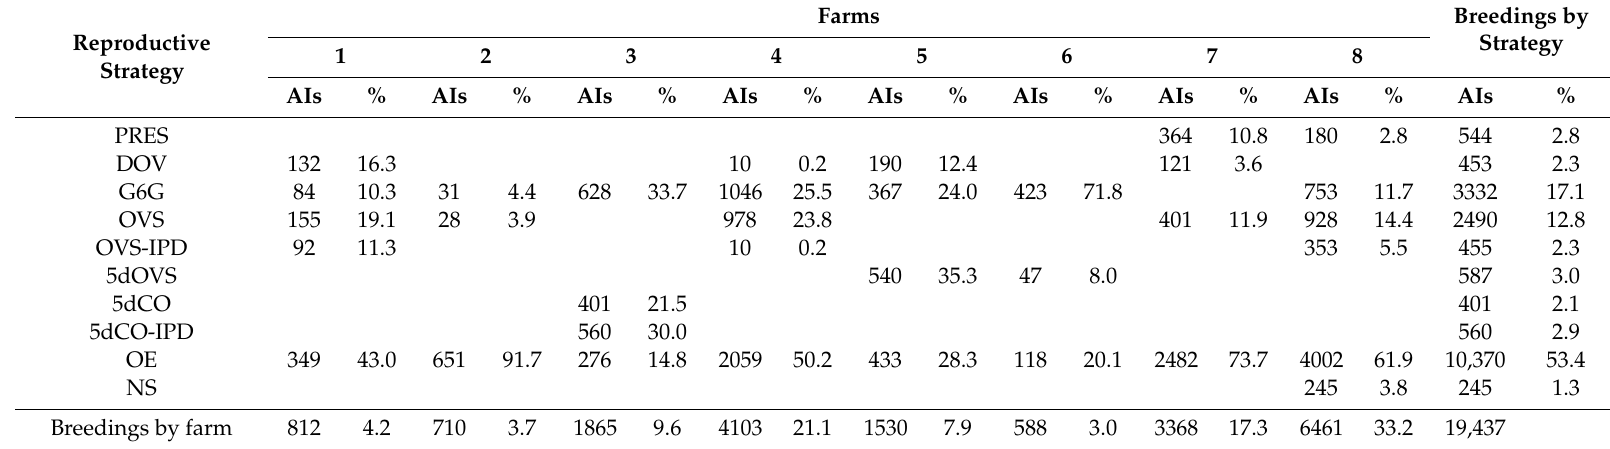
Farms Breedings by